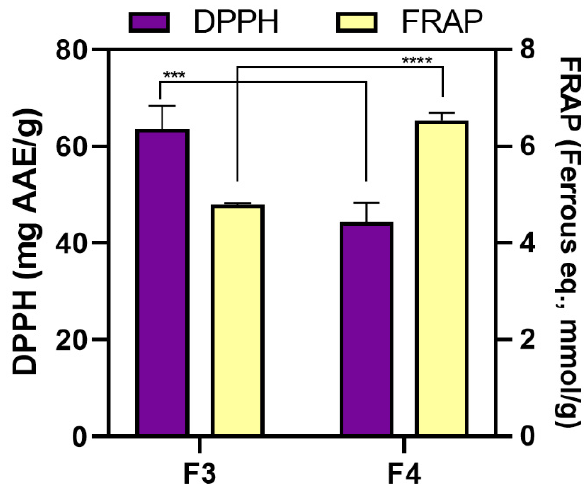
Figure 5. Antioxidant activity of C. adhaerens less polar fractions (F3 and F4) obtained using 2,2- diphenyl-1-picryl-hydrazyl-hydrate (DPPH) and ferric reducing antioxidant power (FRAP) in vitro assays (mean ± SD; n = 3). An asterisk indicates a significant difference between F3 and F4 (*** p < 0.01; **** p < 0.001). Table 5. Antioxidant activity of C. adhaerens fractions (F3 and F4) obtained using ABTS assay with corresponding IC 50 values and the significance parameters (confidence interval, slope and coefficient of determination, R 2